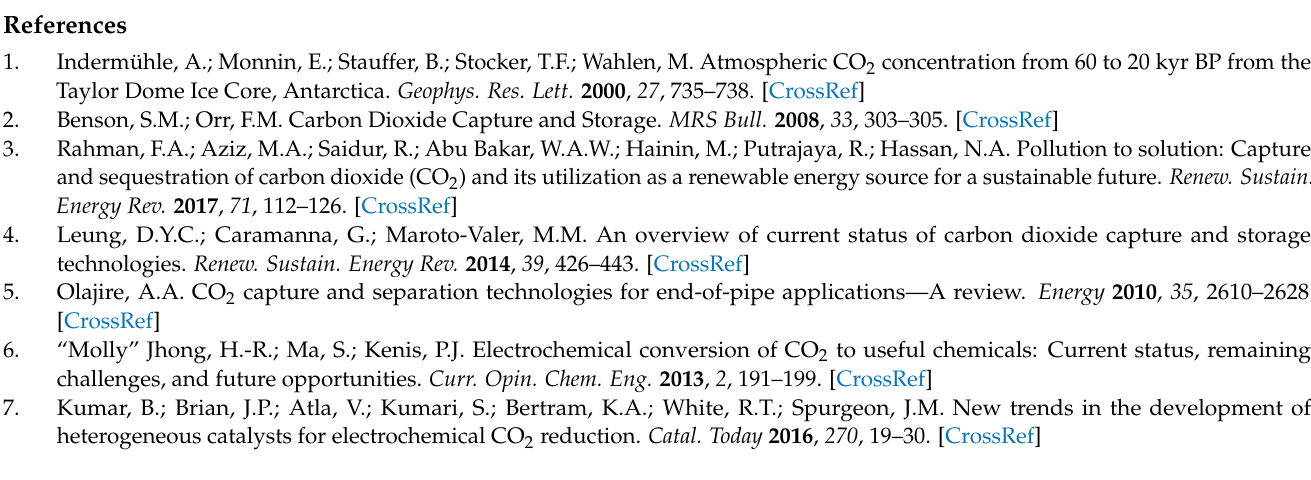
are orthogonal to the planes, spanned by unity cell axes a, b and c. Figure S2: SEM images of synthesized copper materials comprising light (+) and dark ( − ) particle types. CuO/AC shows CuO mixed with activated carbon (commercial products). Figure S3: SEM images of all synthesized copper materials and CuO/AC. Figure S4: X-ray powder diffractograms of all copper catalysts show different copper oxidation states (0, + I and + II). The measurements are normalized to 1. Figure S5: Formation rate of hydrogen, carbon monoxide, ethylene, formate, ethanol and n-propanol for different CO 2 flows and Cu-a catalyst loadings for two hours. The experiments were performed at constant potential E = − 1.7 V vs. Ag/AgCl in CO 2 saturated 0.5 M KHCO 3 ., Figure S6: Products generated by the copper catalyst Cu-g between − 2.1 V, − 1.9 V, − 1.7 V and − 1.5 V in CO 2 saturated 0.5 M KHCO 3 electrolyte. The measurements were performed for half an hour at each potential., Figure S7: Overview of the current densities at − 1.7 V vs. Ag/AgCl. The 0.1 M concentrated electrolyte degrades after ~ 40 min, while the 0.5 M KHCO 3 is stable for about 120 min., Figure S8: Chronoamperograms for synthesized copper catalysts in Argon and CO 2 saturated 0.5 M KHCO 3 . Potentials shown vs. Ag/AgCl., Table S1: Increase of pH during 2 h reaction time., Table S2: Total product formation rates for 2 h reaction time using copper catalyst Cu-a in two different concentrated KHCO 3 electrolytes at E = − 1.7 V vs. Ag/AgCl., Table S3: Faraday efficiencies of all synthesized copper materials at E = − 1.7 V vs. Ag/AgCl in CO 2 saturated 0.5 M KHCO 3 . In this table more detailed information of Figure 4b is